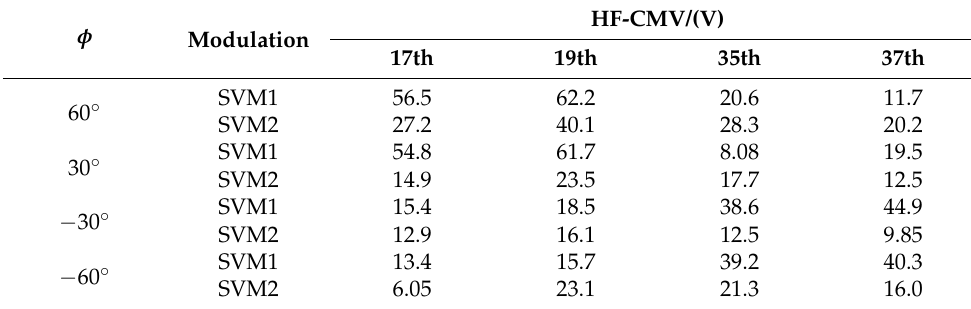
Figure 13. CMV and 𝑖 𝑔𝑎 ( 𝑚 𝑎 = 0.417): ( a ) SVM1 and ( b ) SVM2. Figure 13. CMV and i ga ( m a = 0.417): ( a ) SVM1 and ( b ) SVM2. Table 3. HF-CMVs with Different φ